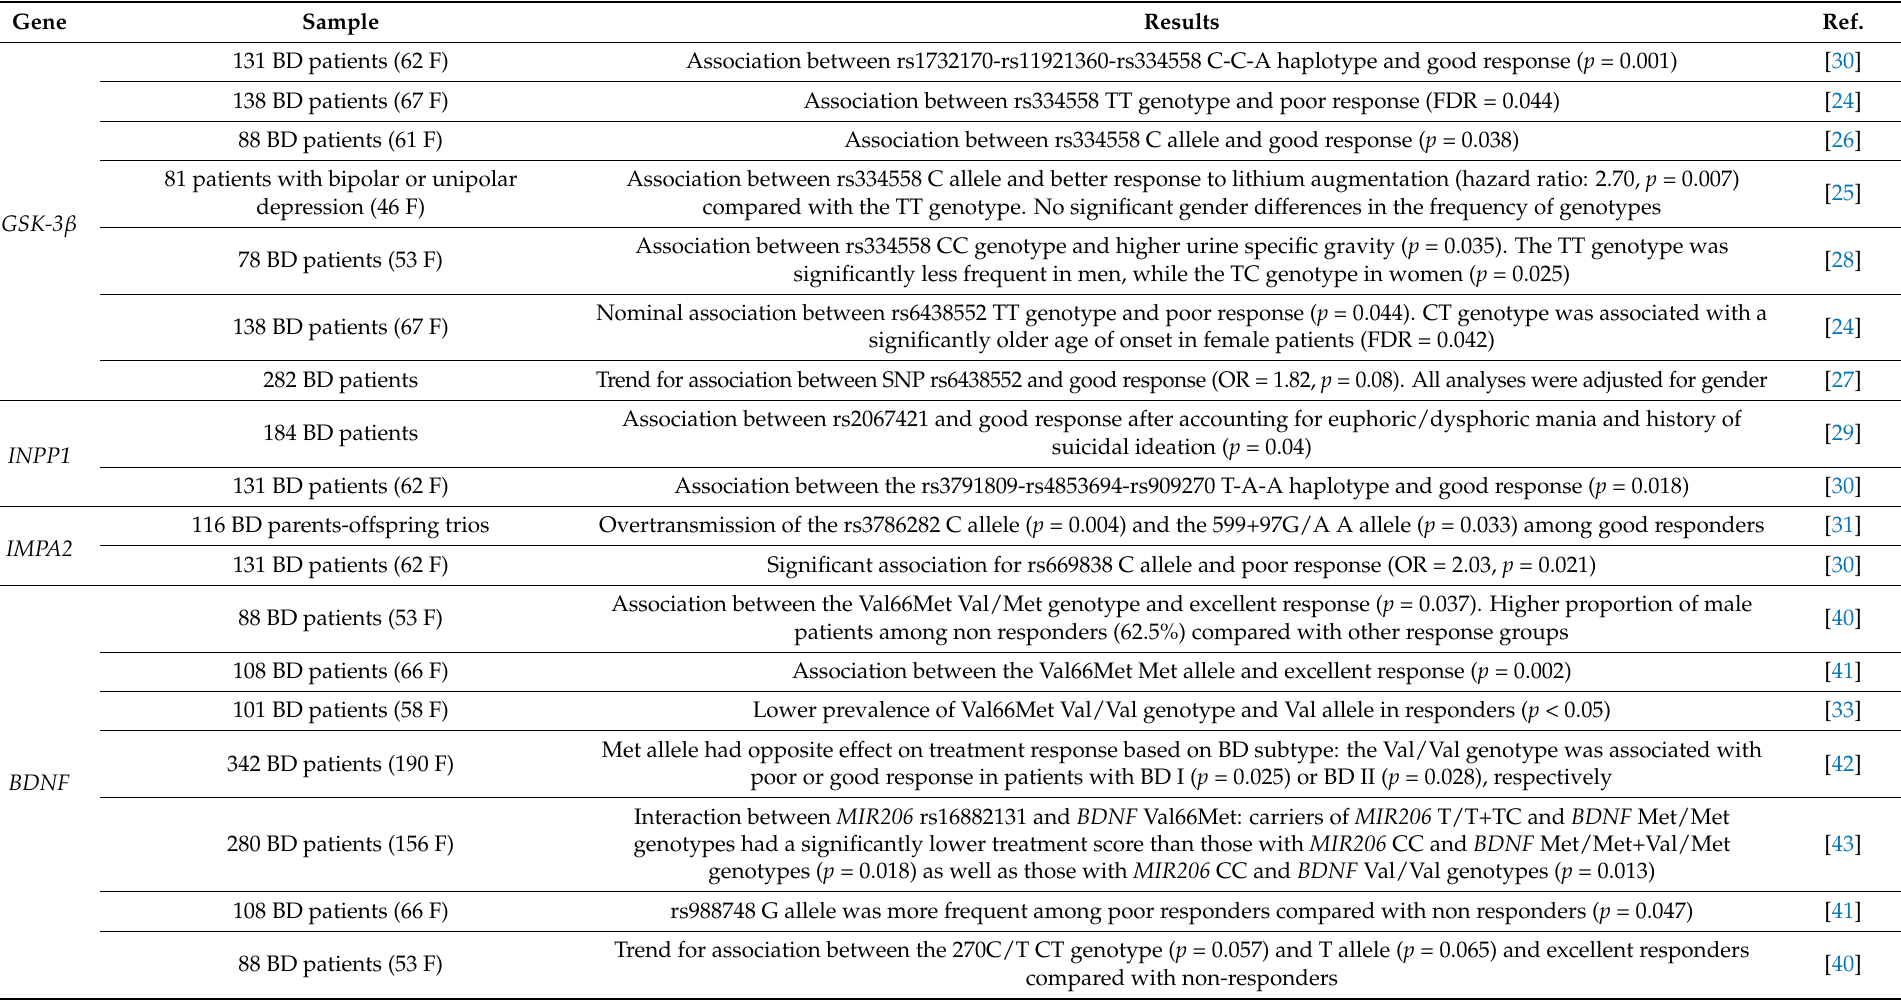
Table 1. Candidate genes for which association with lithium response has been provided by at least two studies including at least 50 patients with